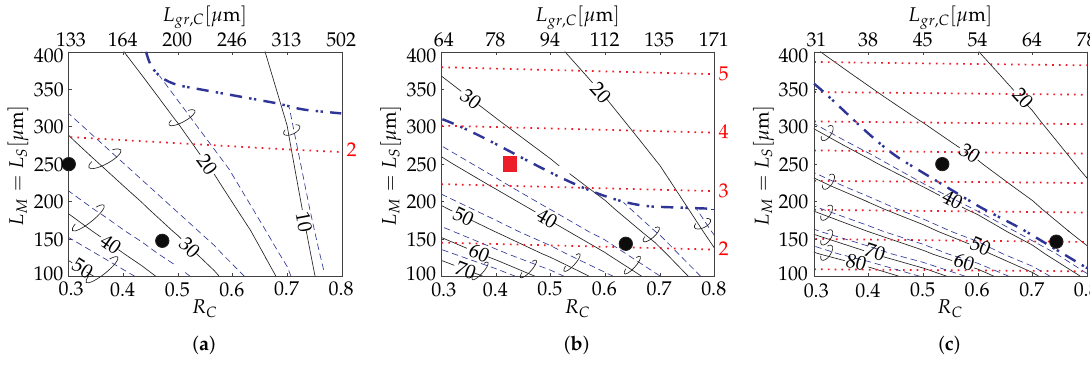
Figure 4. Coupled cavities DBR laser design maps for equal cavity length ( L M = L S ): constant photon-photon resonance (PPR) frequency (in GHz) curves as functions of the central grating reflectivity ( R C ) and for the cleaved (dashed lines map) and grating (continuous lines map) right facet with the same maximum reflectivity R R = 32%. Results are obtained at the laser threshold using the transmission matrix method for a lossless left reflectivity R L = 90% and with κ = 50cm − 1 ( a ), κ = 100cm − 1 ( b ) and κ = 200cm − 1 ( c ). In the area above the double dotted line, where the dashed constant frequency lines are not reported, the PPR conditions are more critical to be found. The red dotted lines, referring to the right vertical axes, indicate the number of longitudinal modes of the slave cavity inside the reflectivity main lobe of the grating with the largest optical bandwidth. The large markers indicate the structures that we have analyzed in their small and large signal modulation responses; the square marker indicates the structure whose dynamic results have been reported in this paper.